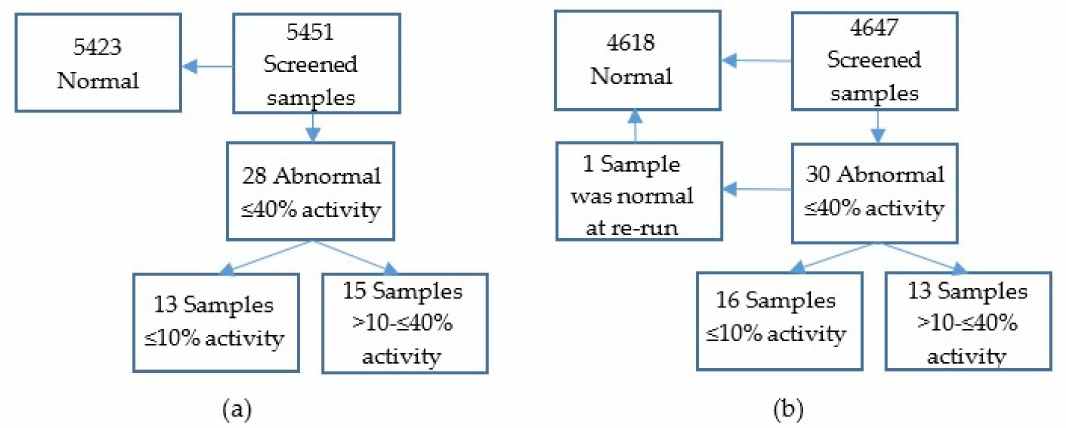
Figure 1. ( a ) Summary of results for samples screened anonymously and analysed as singletons. ( b ) Summary of results for samples screened coded. Abnormal samples were re-analysed in duplicate. Samples with residual enzyme activities ≤ 40% were subjected to Sanger